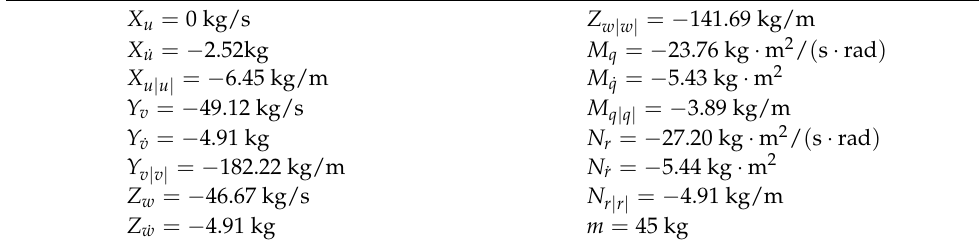
Table 2. The hydrodynamic parameters of X-AUV